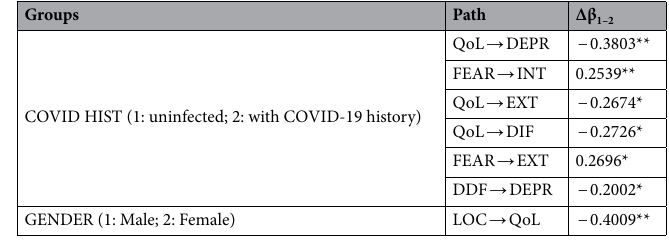
Table 8. MGA results of the